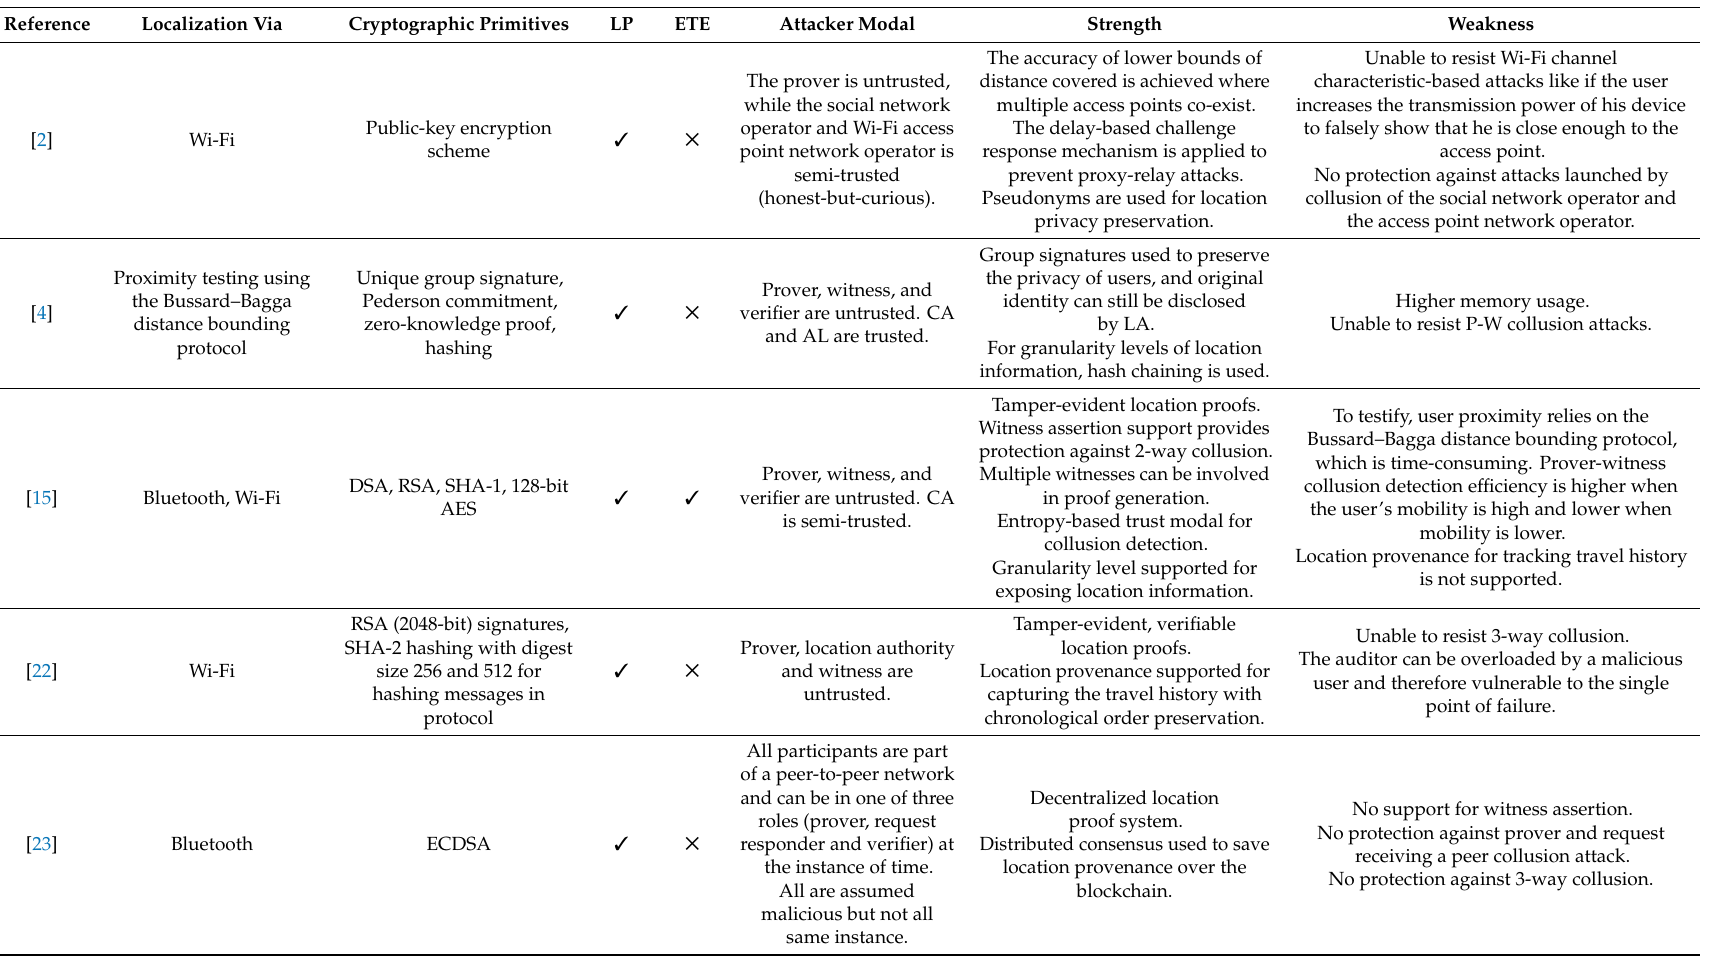
Table 1. Comparative analysis of location proofs system. Abbreviations: entities’ trust evaluation (ETE), location privacy